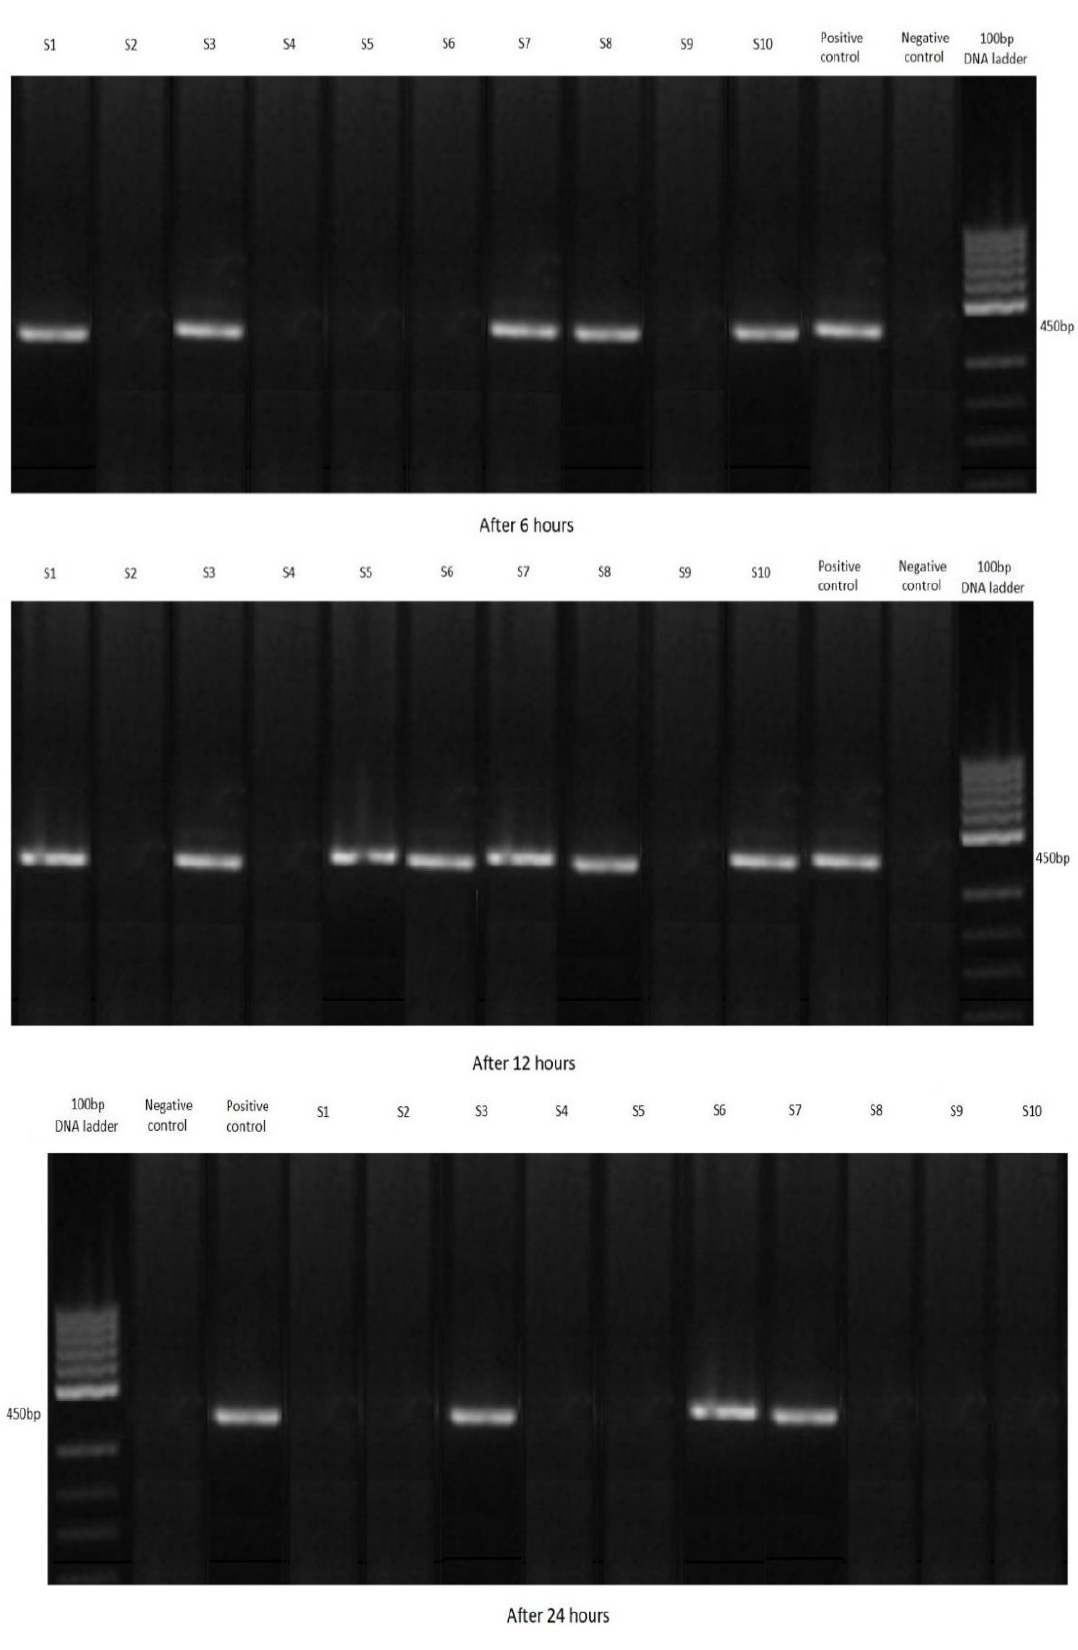
Figure 4. Agarose gel: investigated positivity of water samples for Cryptosporidium parvum with Neocaridina davidi, Group C.